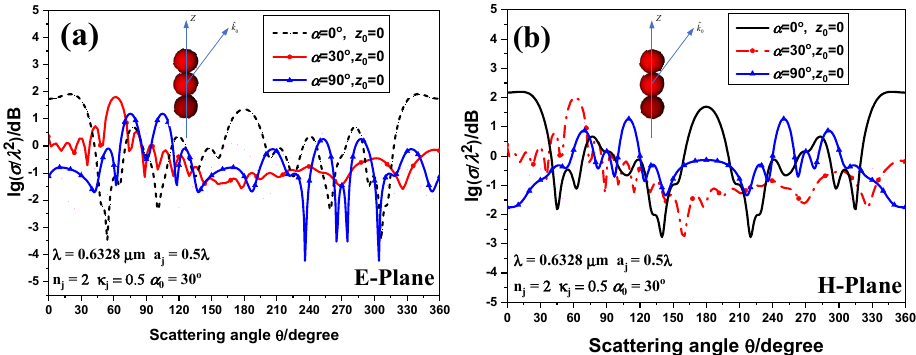
Figure 7. Angular distributions of normalized RCS illuminated by an RCP HOBB depending on the angles of incidence. ( a ) E-plane; ( b ) H-plane.